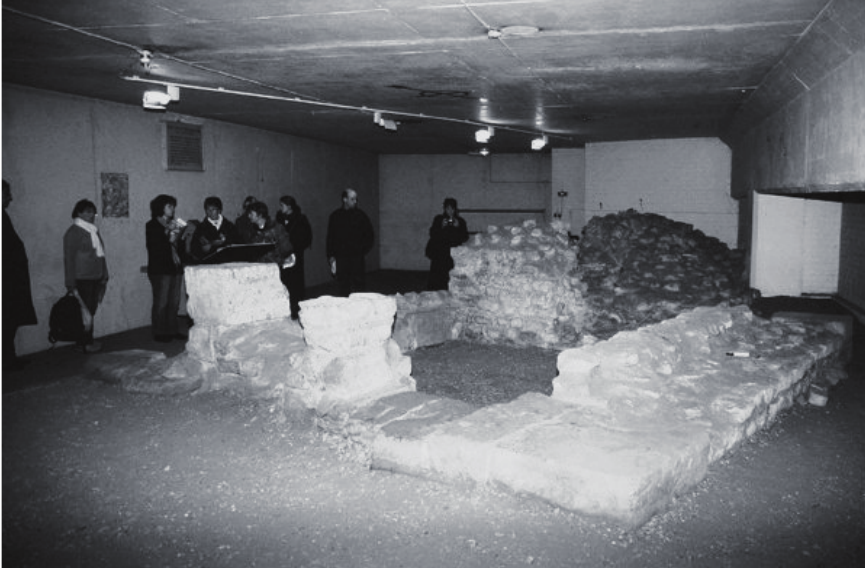
Figure 2. West Gate, Cripplegate, London (Photo by S.